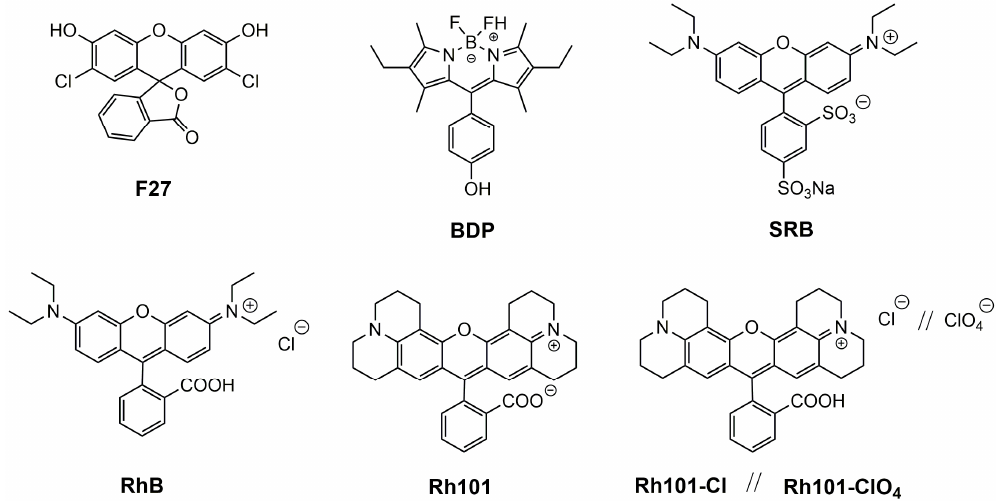
Figure 1. Chemical structures of selected dyes.